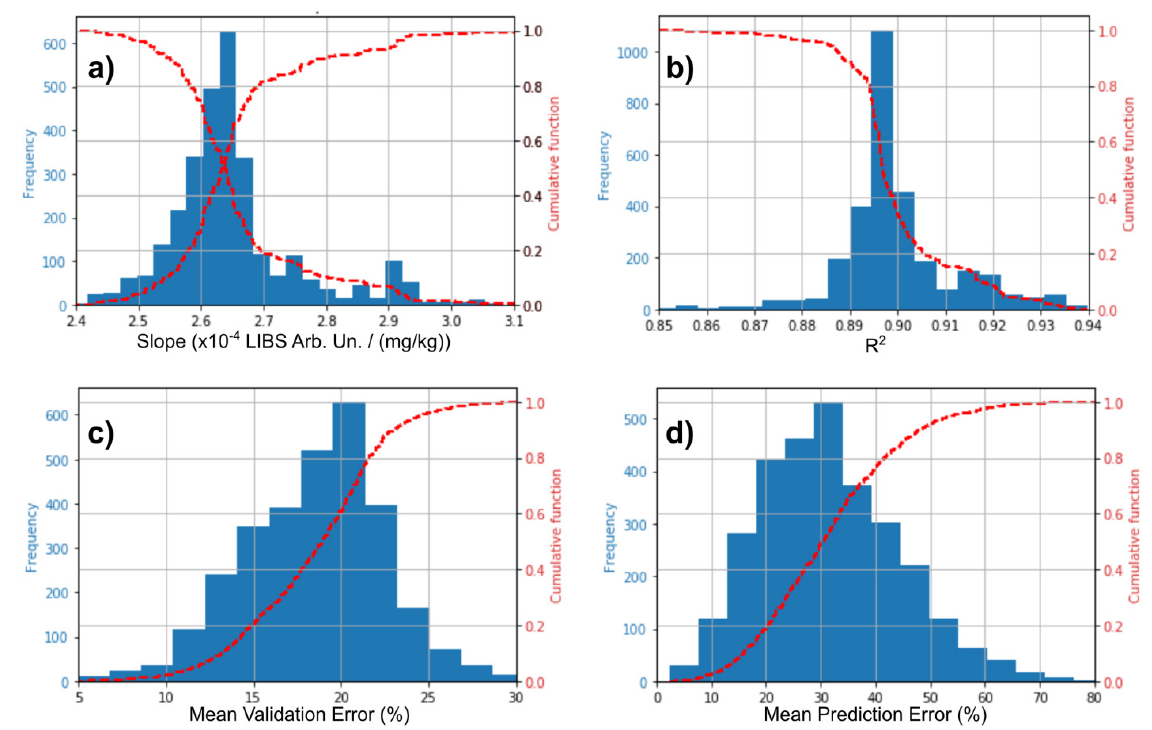
Fig. 5 Histograms and cumulative functions obtained from the calibration, validation, and prediction performed after 3000 repetitions over the samples ensemble a: Fitted slopes, b: R 2 of the fittings, c; Mean percentage absolute validation errors, d: Mean percentage absolute prediction errors